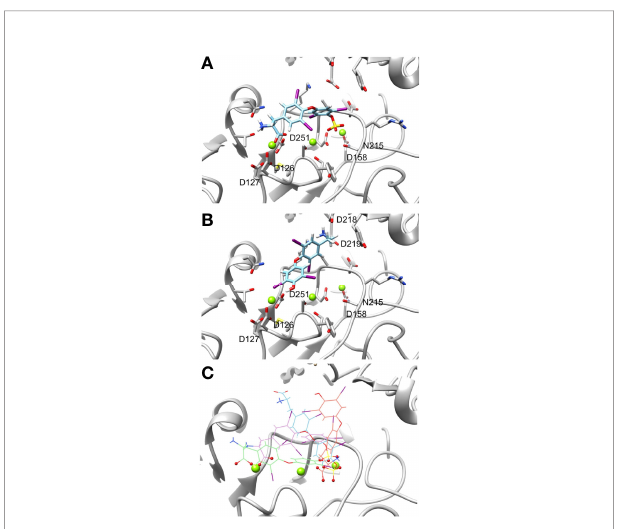
comparison to the non-sulfated hormones ( Table 1 ). However, an exception was observed for T3S, in which amber score was higher compared to the non-sulfated metabolite, with the carboxylic group fl ipped away from the MIDAS site. Docking for T4 and T3 compared to their sulfated forms is depicted in Figure 4 .